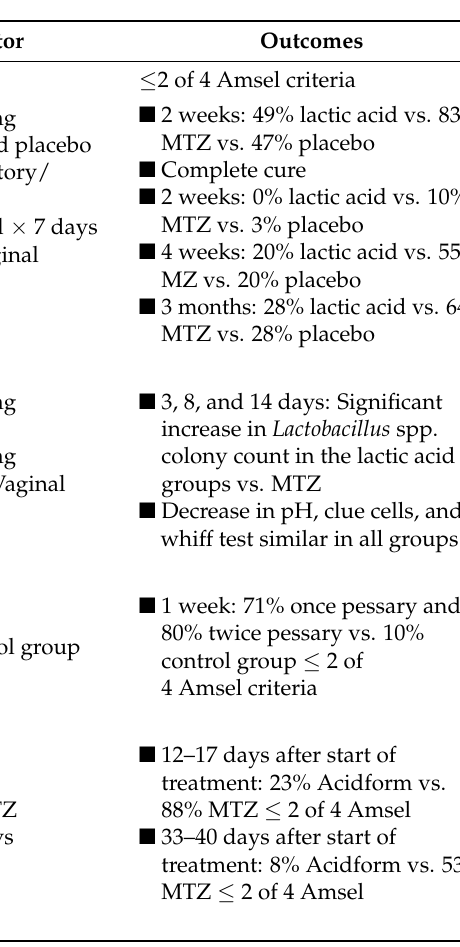
Table 1. Clinical studies evaluating intravaginal lactic acid treatment in women with bacterial